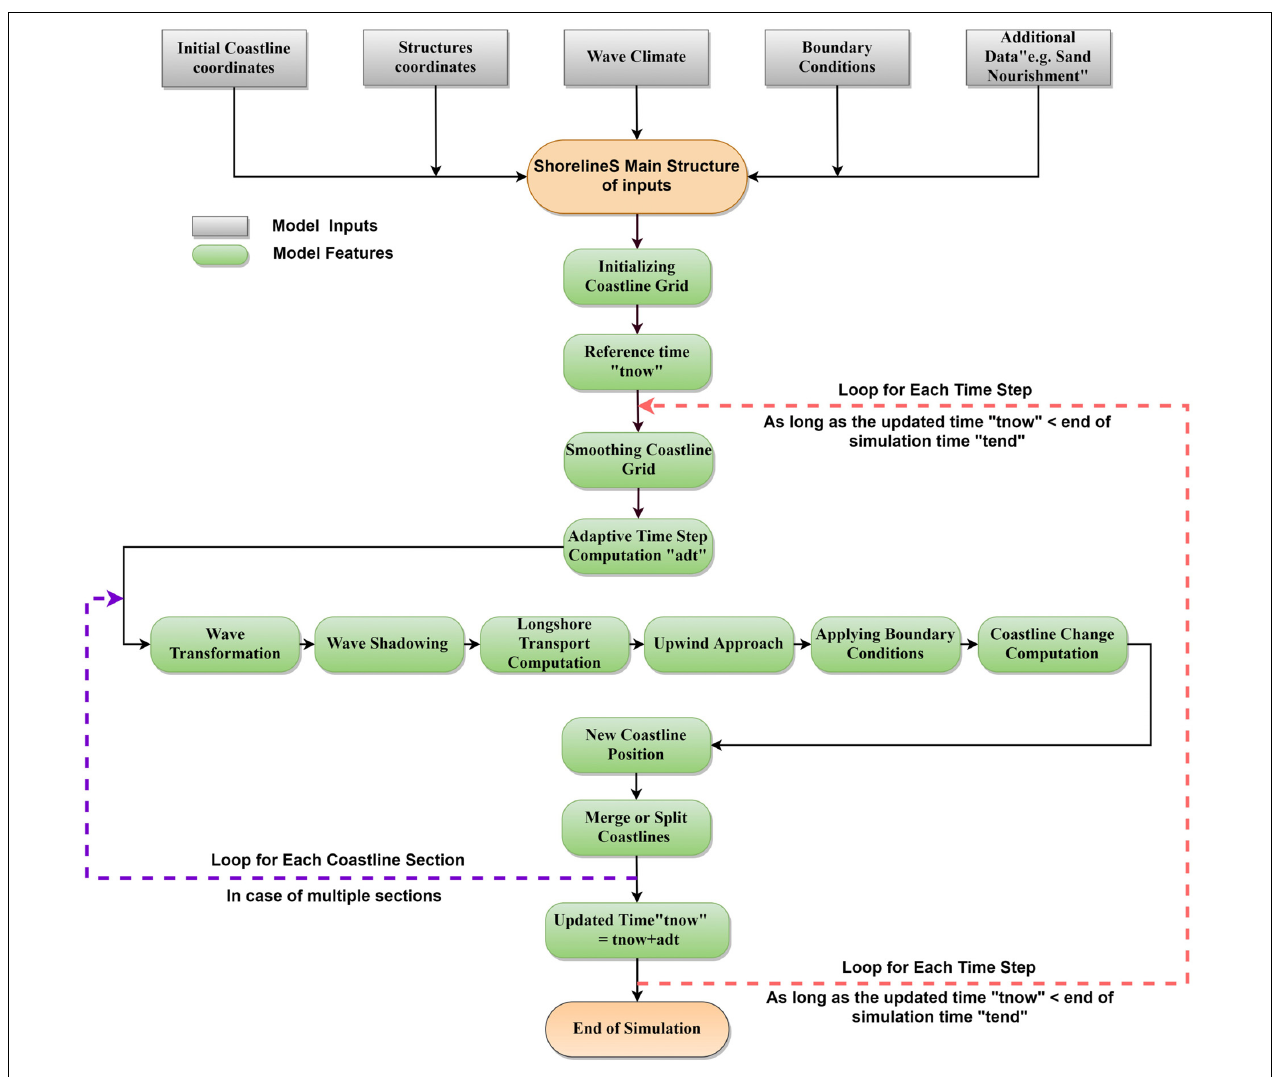
FIGURE 2 | Flow diagram of the ShorelineS model.